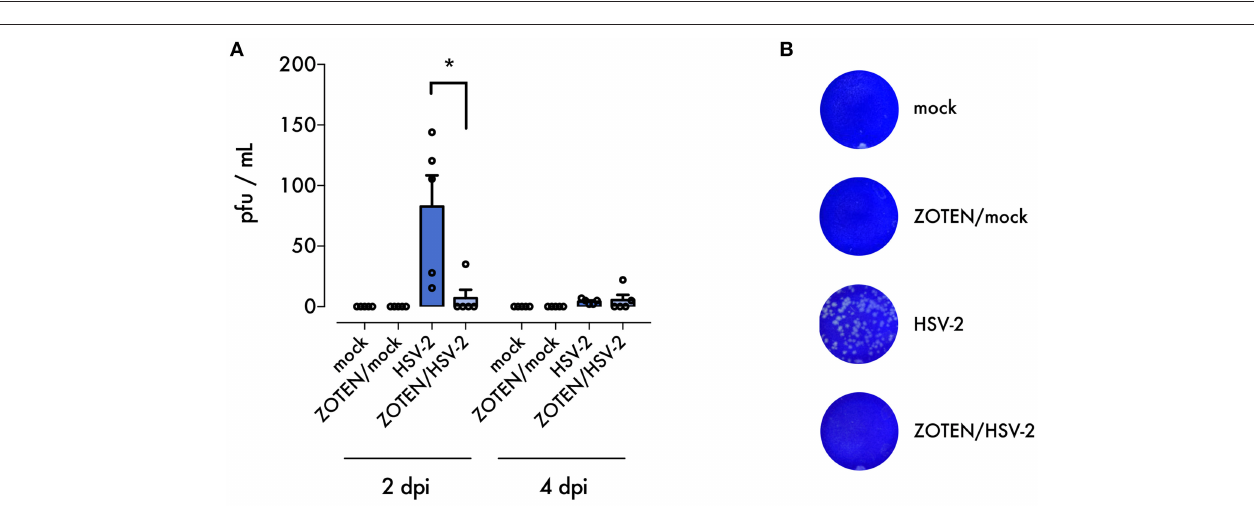
FIGURE 1 | Study design. 6–8 weeks old female BALB/c mice were infected with HSV-2 or mock infected in the presence or absence of ZOTEN. At 2 and 4 days post infection (dpi), mice genitals were swabbed to detect viral shedding using a plaque assay. At 7 dpi, mice were euthanized, and vaginal tissues were extracted and analyzed by histology, flow cytometry, and quantitative PCR (qPCR) to appreciate differences in cellular infiltration and local inflammation.